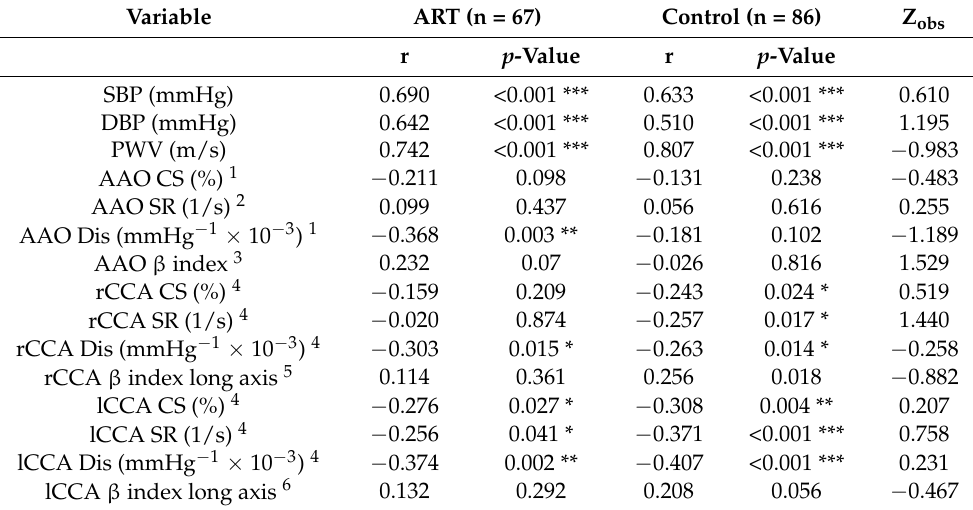
Table 5. Correlation Analysis between Age and Vascular Function in the ART and Control